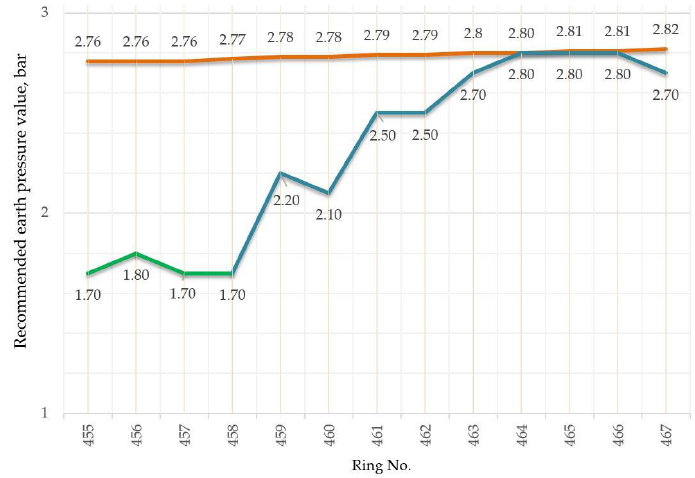
Figure 2. The recommended value at the top of the crown and the actual earth pressure.